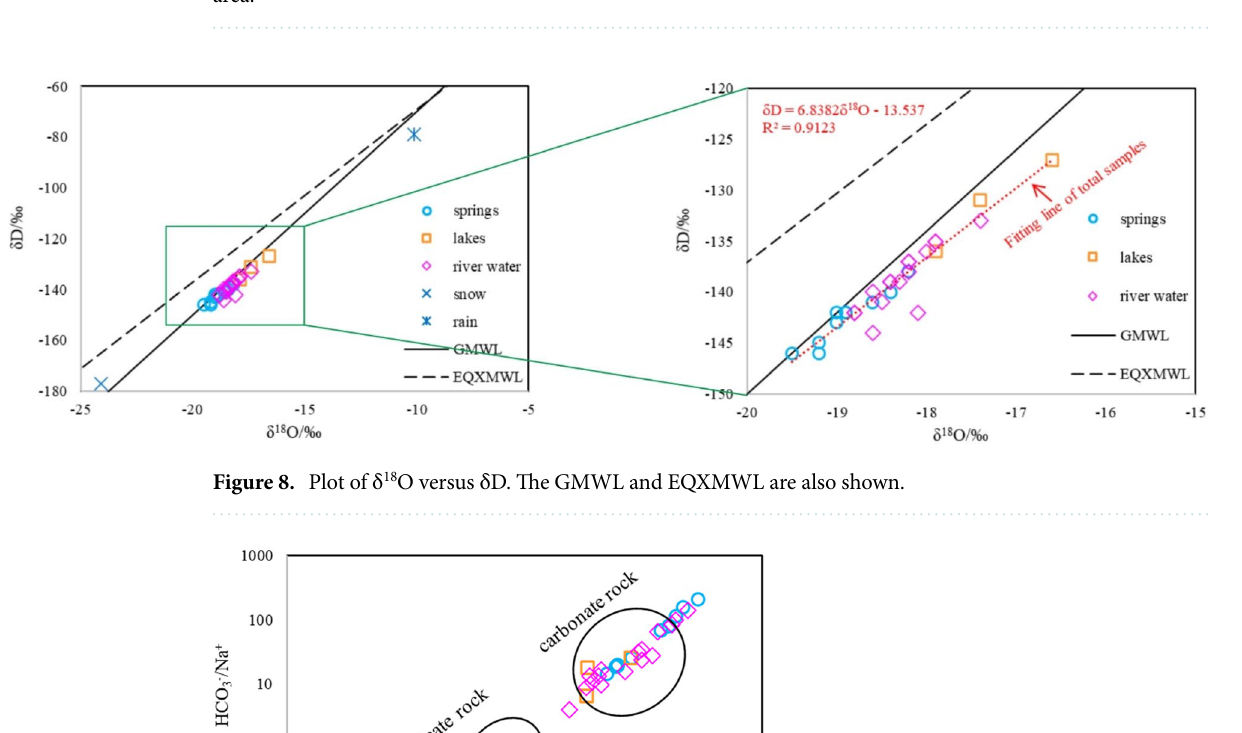
Figure 7. Calculated elevation of recharge areas, spring elevations, and flow of karst springs within the study area.